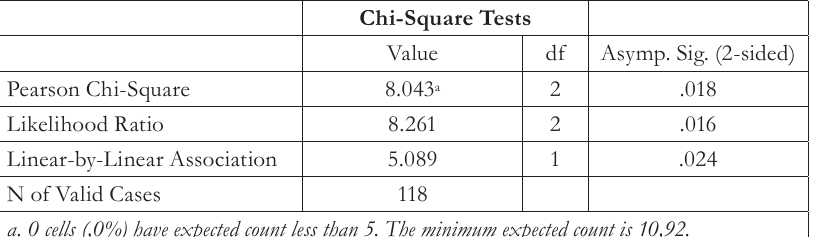
Tab. 7 - Satisfaction with the benefits of student bank accounts versus nationality. Source: Author´s own,